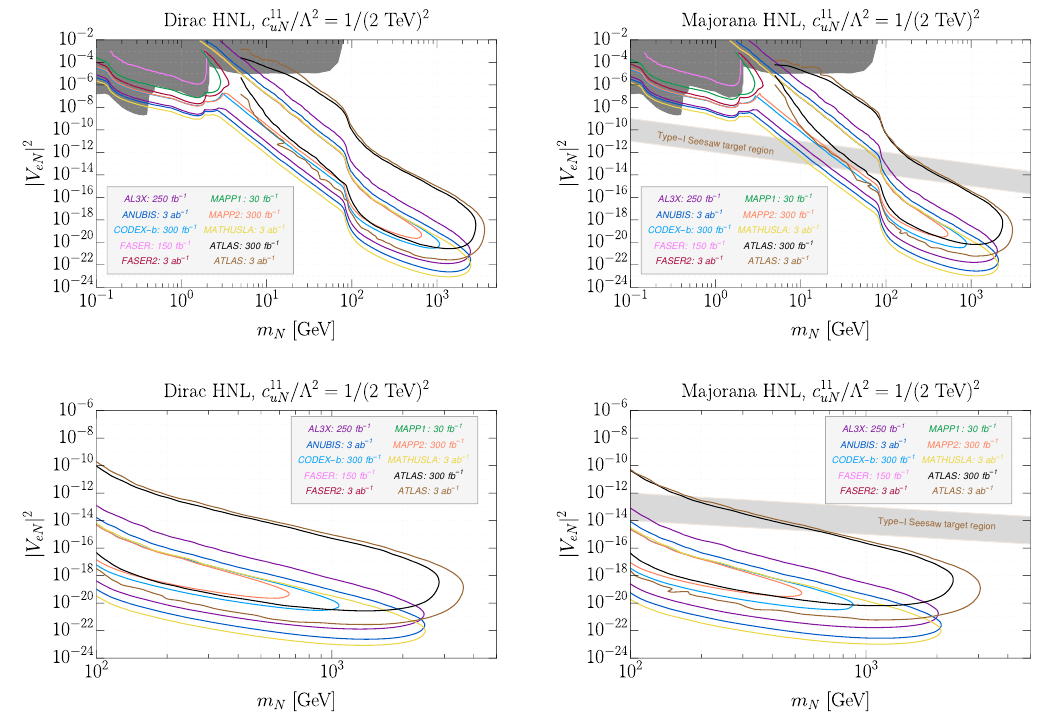
Figure 6 . Experimental sensitivity reach for | V eN | 2 as a function of m N . The plots consider one single operator O uN only. The values of the operator coefficient is fixed to c 11 Limits have been obtained for Dirac (left) and Majorana (right) HNLs. The plots in the bottom row zoom in to the HNL masses larger than 100